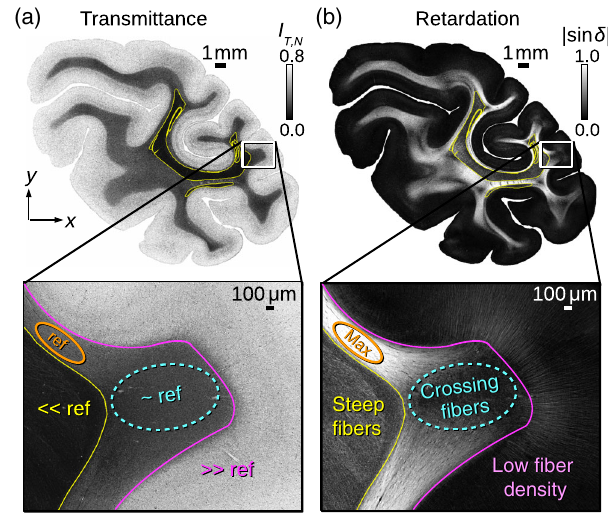
FIG. 6. Combined analysis of transmittance and retardation images allowing the classification of brain regions with low birefringence signals in 3D-PLI measurements. The figure shows the normalized transmittance image ( I ) and the retardation T;N image ( j sin δ j ) of a coronal section through the right hemisphere (occipital lobe) of a vervet monkey brain [cf. Fig. 13(a) in Appendix B 2] obtained from a 3D-PLI measurement with 1 . 33 μ m pixel size. The transmittance in the region with maximum retardation (orange ellipse) is used as a reference value: Regions with small retardation values and notably lower transmittance values (regions surrounded by a yellow line) are expected to contain steep (out-of-plane) fibers. Regions with small retardation values and similar transmittance values (cyan) are expected to contain flat (in-plane) crossing fibers. Regions with small retardation values and larger transmittance values (purple) belong to regions with low fiber density, i.e., regions with a large amount of unmyelinated axons or surrounding